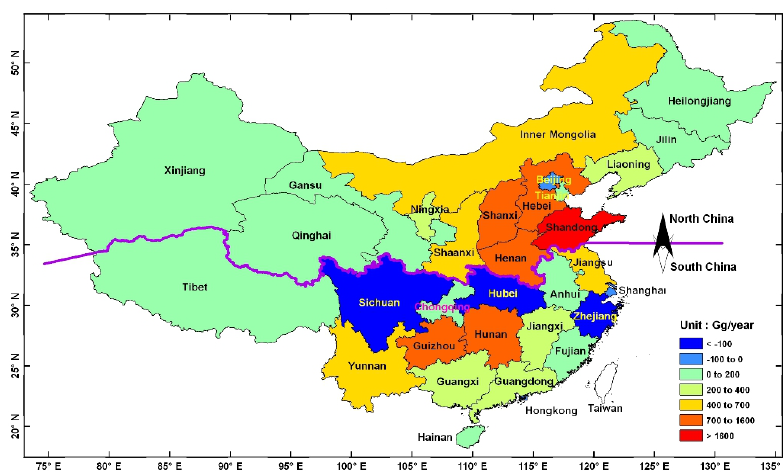
Fig. 3. Provincial change of SO 2 emission in China between 2000 and 2006. Purple solid line indicates the dividing line of north and south